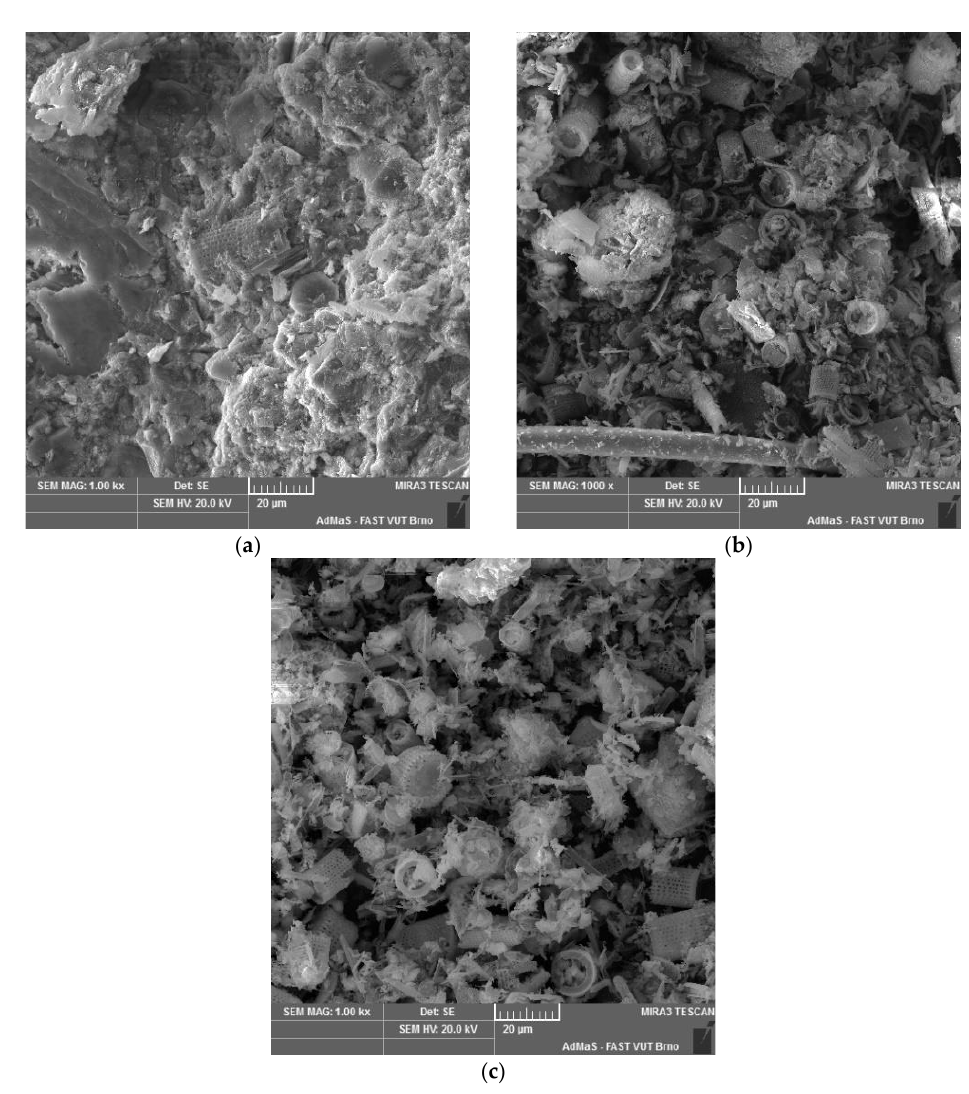
Figure 2. SEM analysis of diatomaceous earth ( a ) ENO3, ( b ) ENO7, ( c ) BOR. Physical parameters tested characterize raw materials from the view of size, shape, distribution, and especially specific surface of particles. The specific density of analyzed powders was also researched. a laser diffraction working device, Analysette 22 Micro Tec plus, Fritsch. The calculated values of particle volume fraction 10, 50, and 90% corresponding to the particle size are presented in Table 5. The particle size distribution curves of tested diatomaceous earth compared to PC CEMI 42.5 R are introduced in Figure